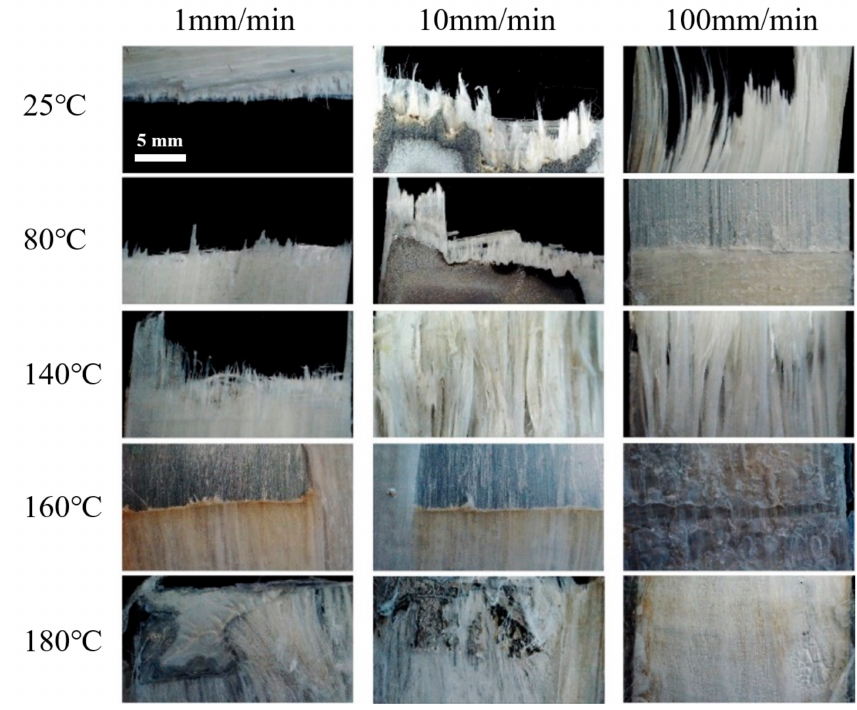
Figure 7. Failure forms of tensile test samples.